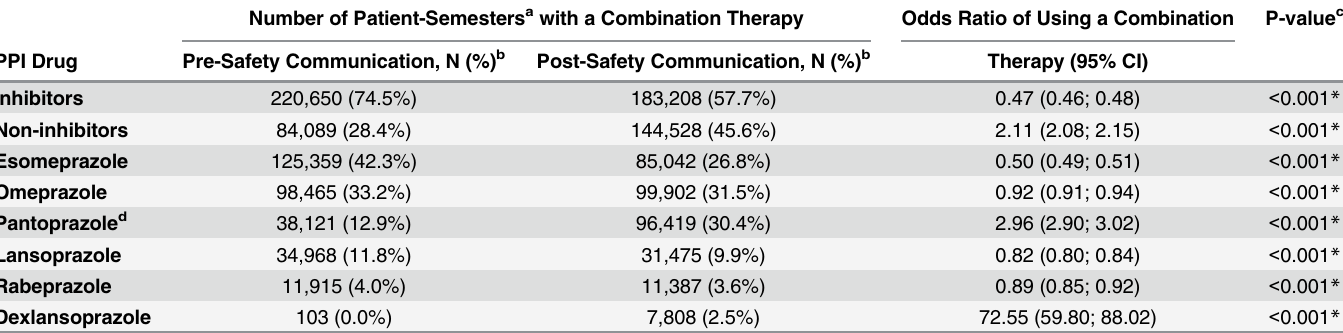
Table 2. Among combination therapy users, relative proportions of each PPI: pre- vs. post- safety communication a - ( (cid:3) 2009 S1 vs. (cid:1) 2009